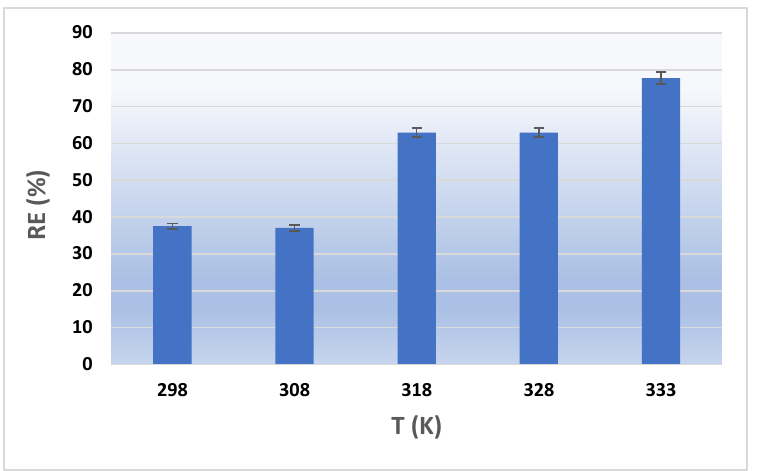
Figure 12. Effect of temperature on the dye removal efficiency (m = 0.01 g, C 0 = 90 mg L −1 , V = 10 mL, pH = 4, and time =48 h).